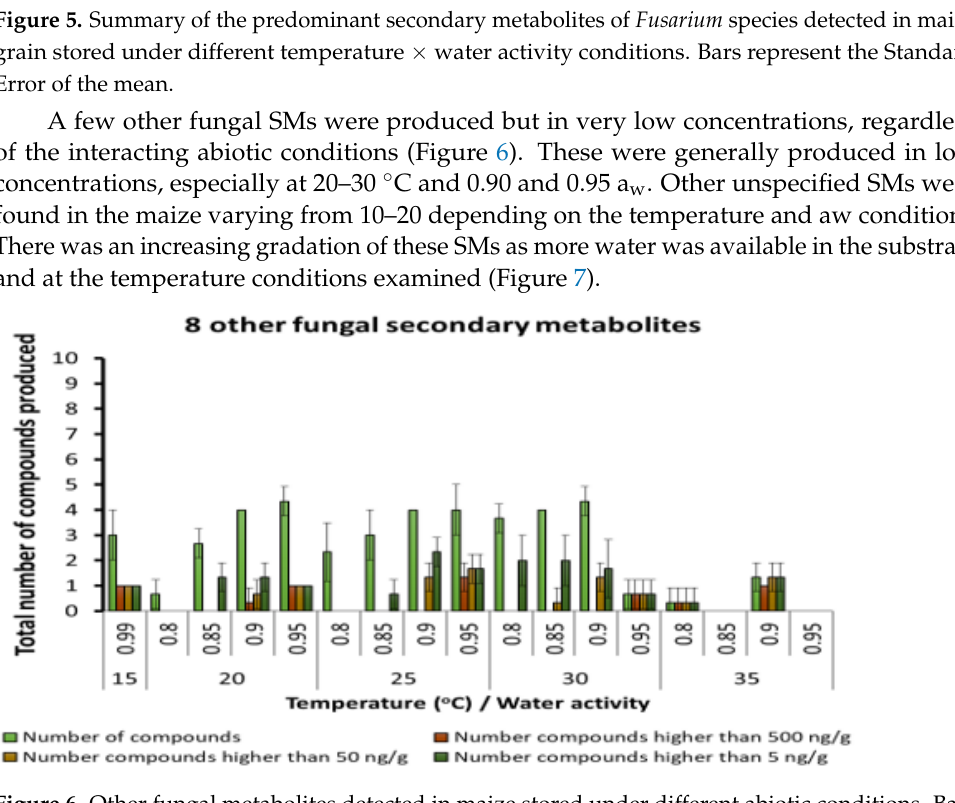
Figure 7. Unspecified secondary metabolites detected in the maize samples under different temper- ature × water activity conditions. Bars represent the Standard Error of the mean. Note change in scale to 0–20 metabolites.